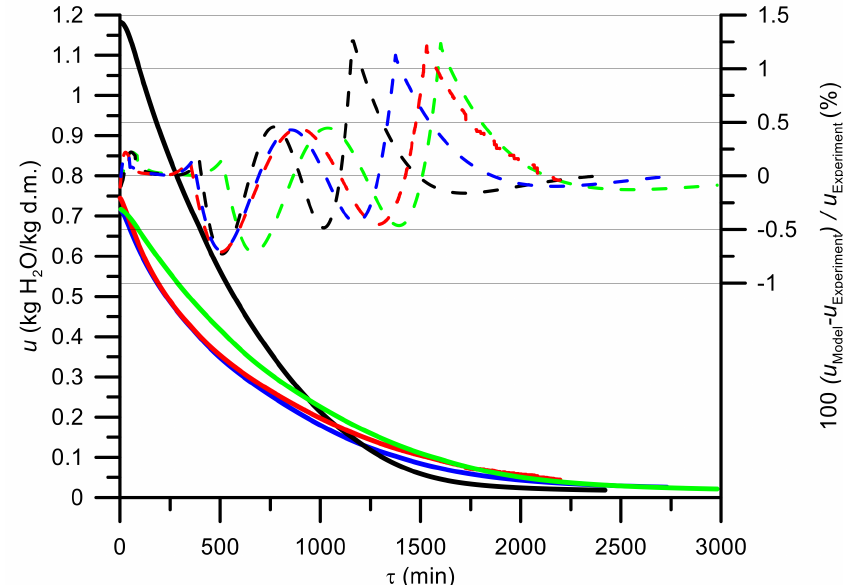
Figure 2. A graph of moisture content versus time of osier (——), rose (——), poplar (——), and acacia (– – –) drying at 60 ◦ C and results of mathematical modeling of osier (– – – RMSE = 0.0007), rose (– – – RMSE = 0.0006), poplar (– – – RMSE = 0.0011), and acacia (– – – RMSE = 0.0007) drying at 60 ◦ C.